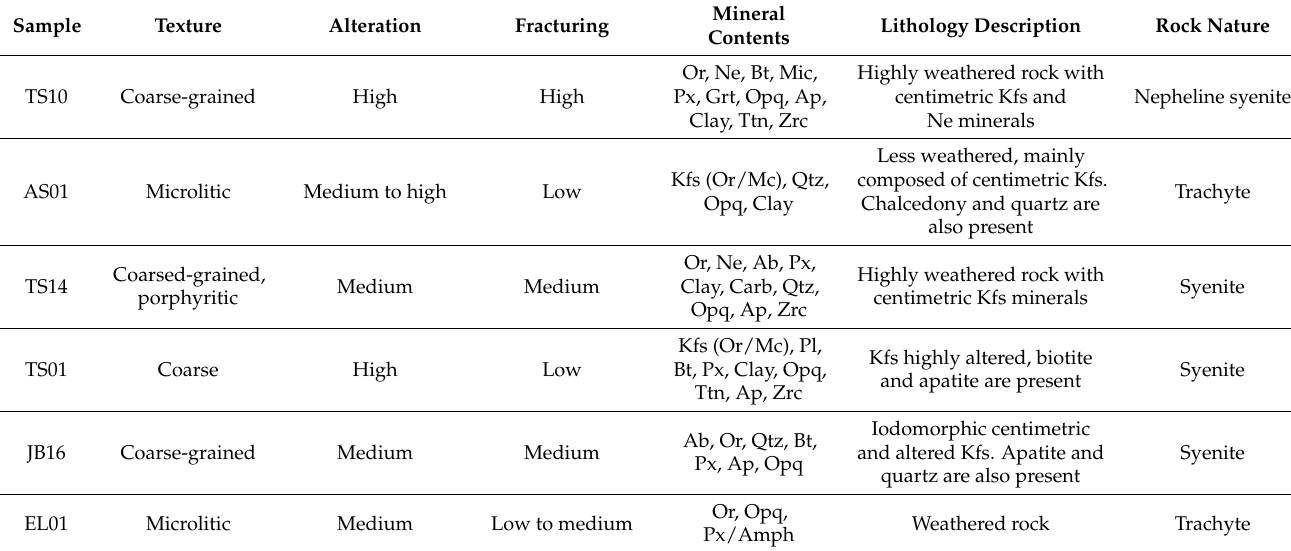
Table 1. Mineral composition and brief description of the selected samples based on petrographical observation. Nepheline (Ne), garnet (Grt), biotite (Bt), Mica (Mic) Fe-Ti oxides (Opq), orthoclase (Or), apatite (Ap), chlorite (Chc), quartz (Qtz), albite (Ab), potassic feldspar (Kfs), pyroxene (Px), amphibole (Amph), titanite (Ttn), zircon (Zrc), plagioclase (Pl), carbonates (Carb), microcline (Mc), and clay minerals